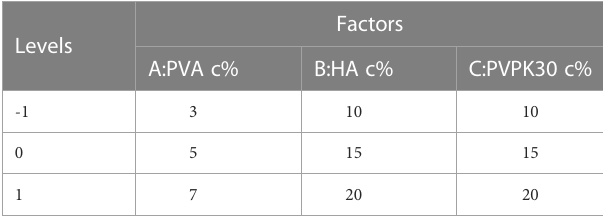
of MGH rats by 16S RNA high-throughput sequencing. Figure 1 depicts the concept for the research.